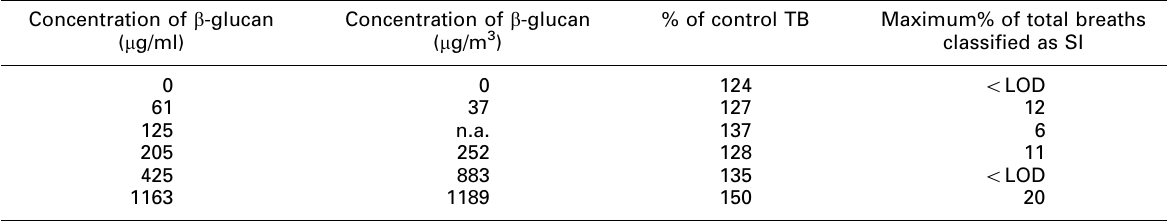
Table 3. Respiratory effects of single b -glucan inhalation exposure on OF1 mice Concentration of b -glucan ( m